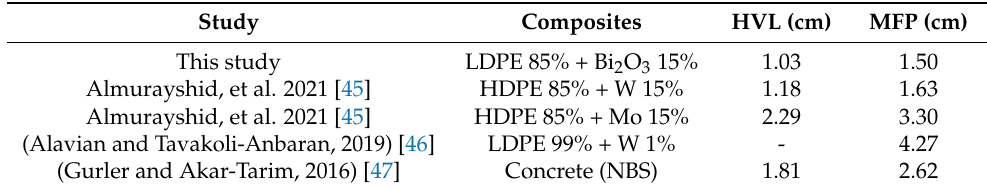
Table 9. Comparison of the measured HVL and MFP outcomes with other materials in the literature at 100